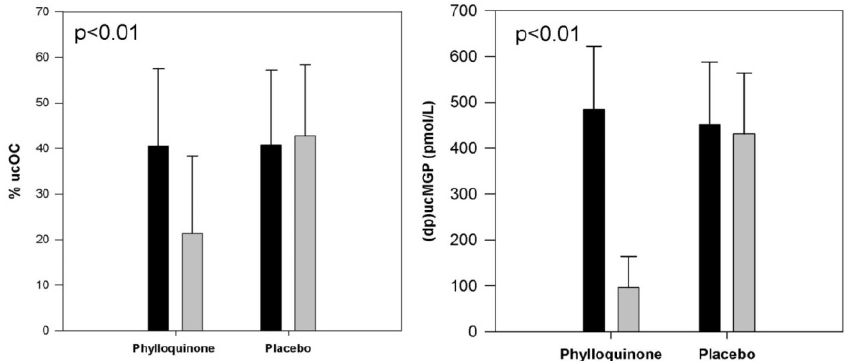
Figure 4. Circulating biomarkers at baseline ( (cid:4) ) and after 3 years ( ) of supplementation with 500 μ g/day phylloquinone ( n = 229) or placebo ( n = 223) in primarily Caucasian community ‐ dwelling